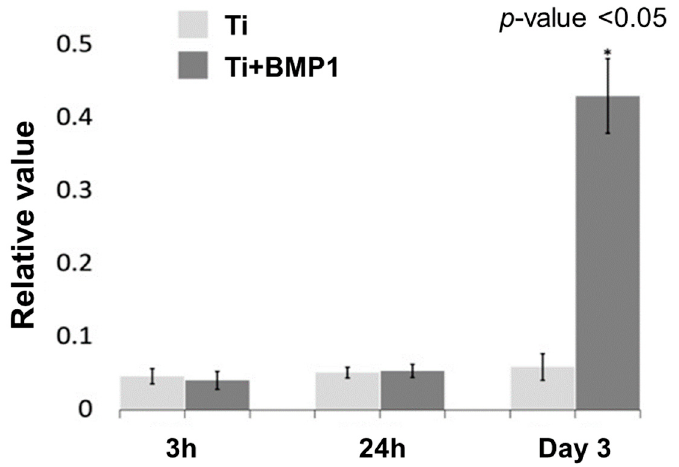
Figure 4. The absorbance value of the (mean ± SD) of attach cell and cell proliferation assay absorbance for titanium coated and control disks at 3 and 24 h and Day 3.